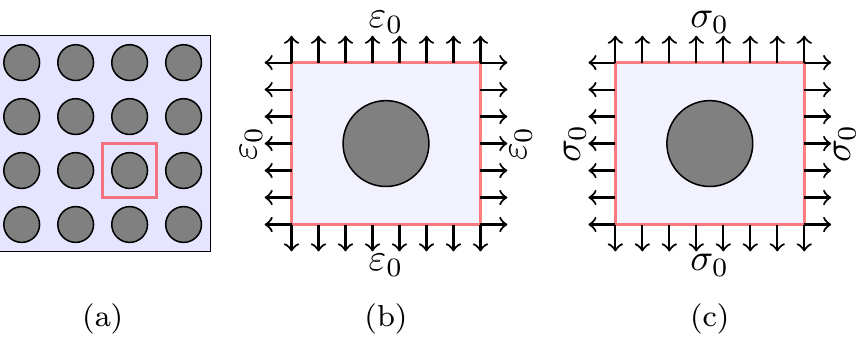
Figure 1. ( a ) Cross section of composite material. Representing the RVE based on ( b ) Vogit and ( c ) Reuss